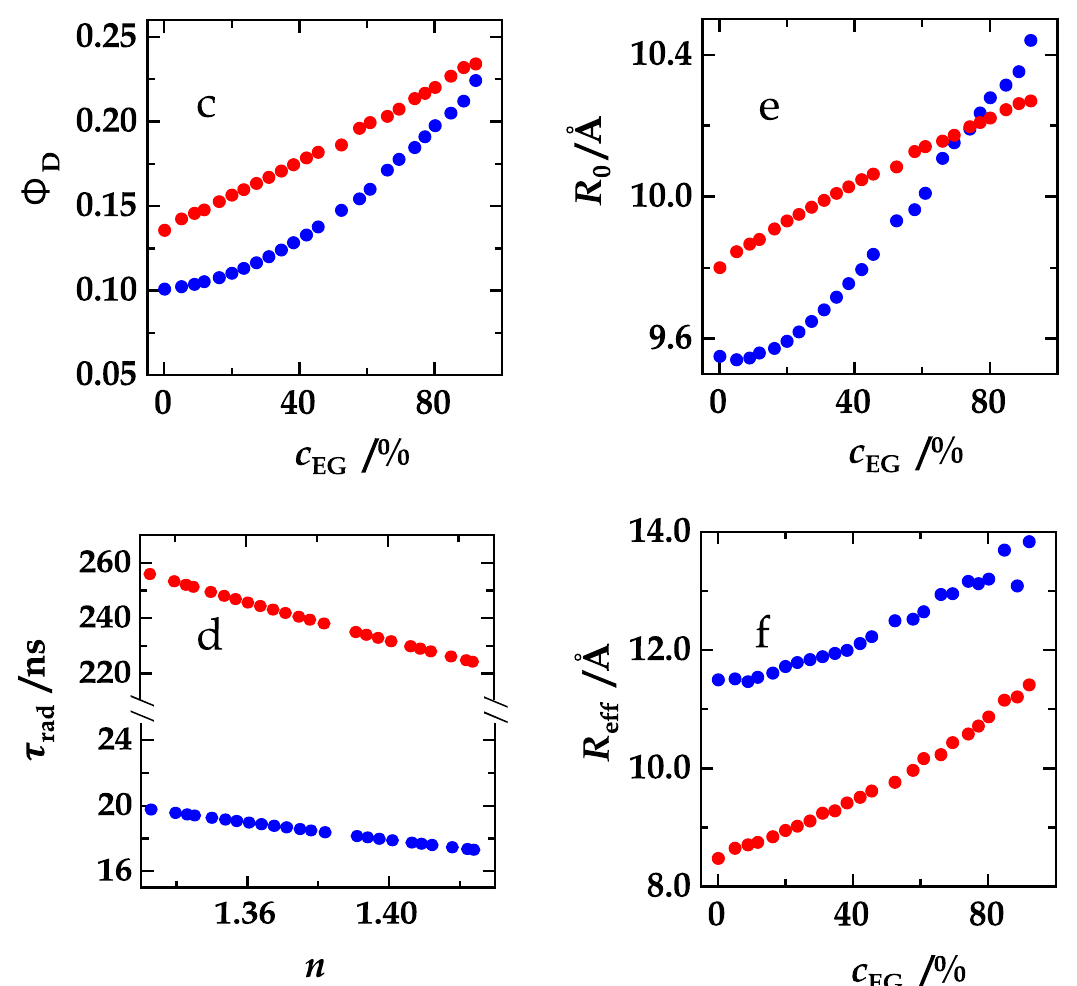
Figure 4. ( a ) Viscosity and ( b ) refractive index of aqueous ethylene glycol solutions plotted against the ethylene glycol concentration. ( c ) Donor quantum yield of NAla in NAla-(GS) 6 -NH 2 (red) and of 5-F-Trp in 5-F-Trp-(GS) 6 -NH 2 (blue) plotted against ethylene glycol concentration. ( d ) Radiative lifetimes of NAla in NAla-(GS) 6 -NH 2 (red) and of 5-F-Trp in 5-F-Trp-(GS) 6 -NH 2 (blue) plotted against the refractive indices that correspond to the ethylene glycol concentrations shown in ( b ). ( e ) Förster radii of the NAla/Dbo donor/acceptor pair in NAla-(GS) 6 -Dbo-NH 2 (red) and of the 5-F-Trp/Dbo donor/acceptor pair in 5-F-Trp-(GS) 6 -Dbo-NH 2 (blue) plotted against ethylene glycol concentration. ( f ) The effective donor/acceptor distances in NAla-(GS) 6 -Dbo-NH 2 (red) and in 5-F-Trp-(GS) 6 -Dbo-NH 2 (blue) plotted against the ethylene glycol concentration.